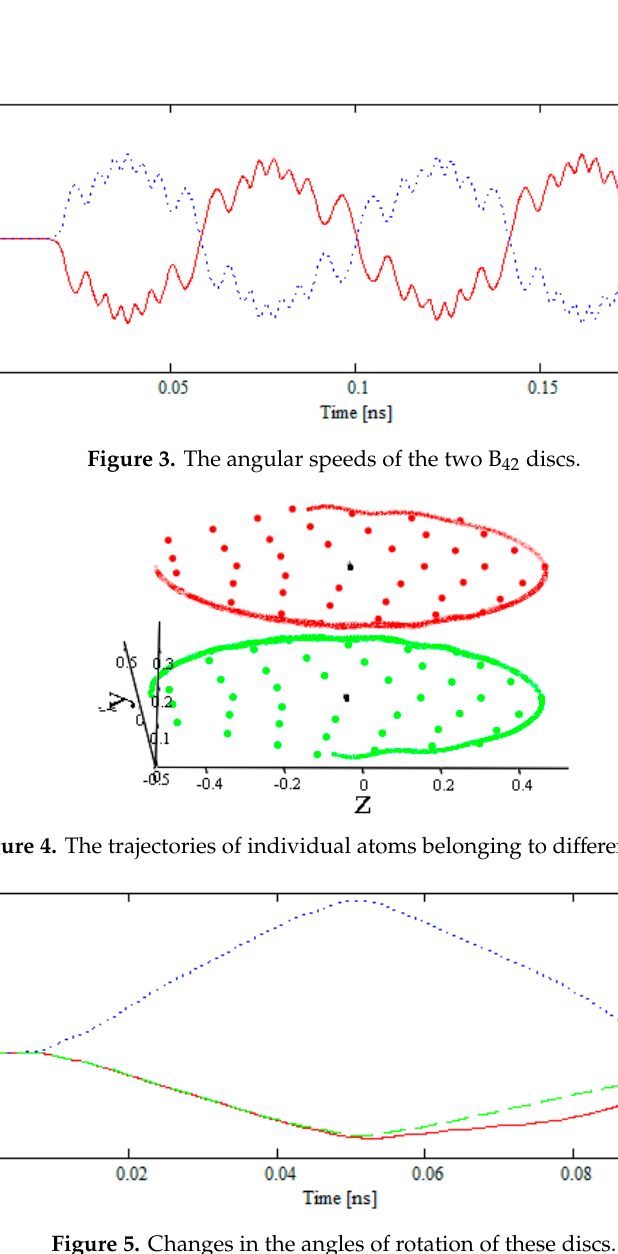
Figure 5. Changes in the angles of rotation of these discs.